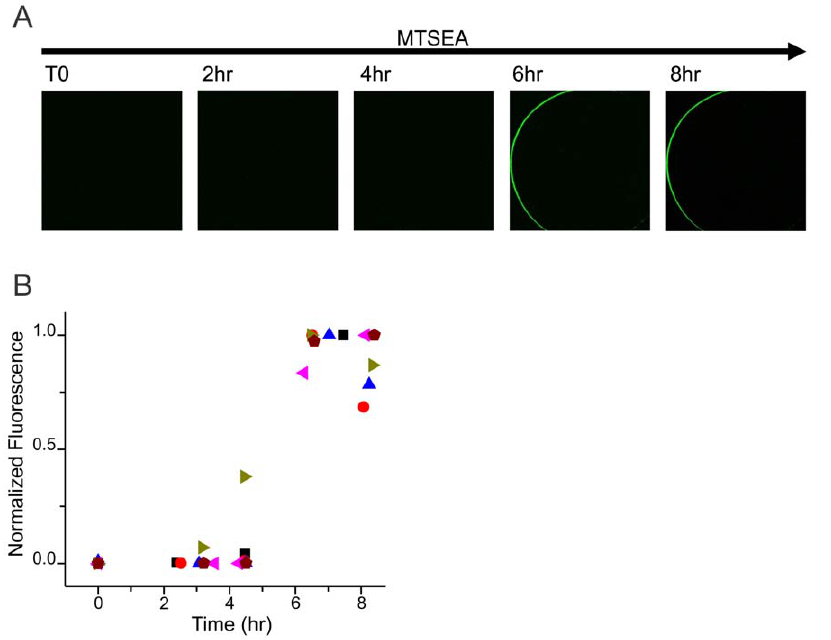
Figure 2. Time course of cell surface expression for R272C CNGA1-GFP channels exposed to MTSEA. A. Representative confocal images of one oocyte before (T0) and after 2 mM MTSEA exposure. Media with fresh MTSEA was exchanged every 30 min. After , 6 hrs of MTSEA treatment, GFP fluorescence was detectable at the oocyte’s surface. B. Plot shows the time course of cell surface fluorescence detection in six different oocytes.